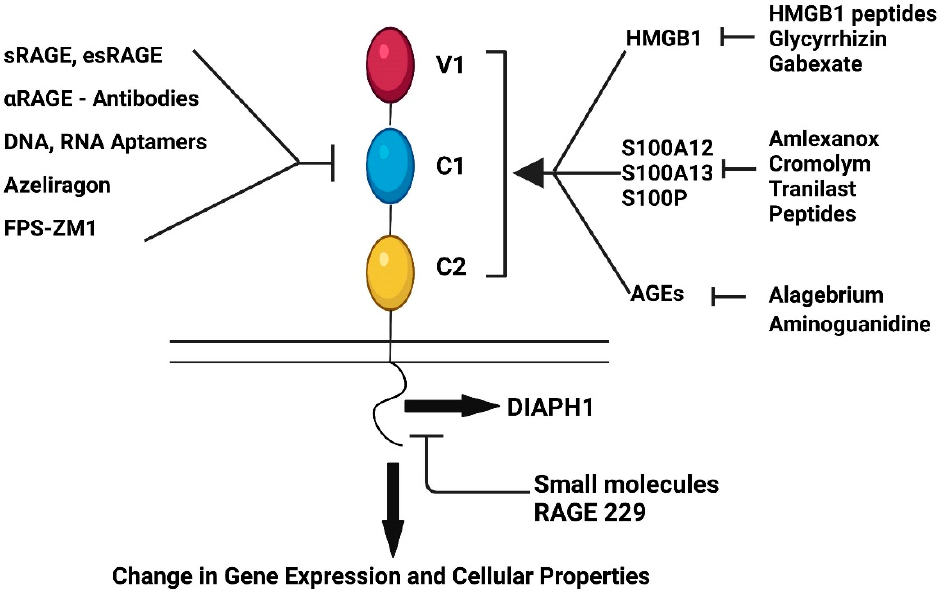
Figure 2. Examples of RAGE-directed therapies. Shown in the Figure ( left side) are examples of strategies that target one or more of the RAGE extracellular domains; shown in the Figure ( right side) are examples of strategies that target the ligands that may bind to RAGE. At Figure center, bottom, are depicted examples of strategies that target the interaction of the RAGE cytoplasmic domain with DIAPH1.